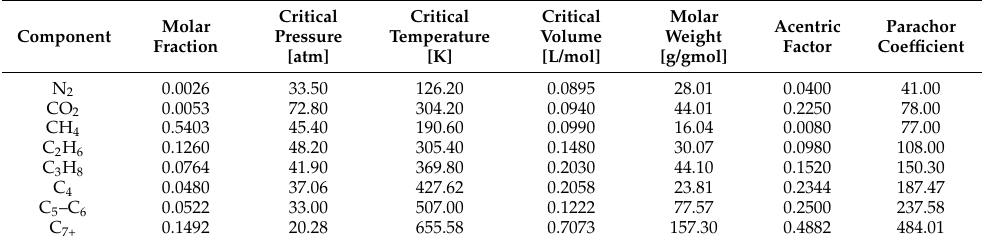
Figure 1. Gas-to-oil ratio (GOR) in the Duvernay shale and the location of the subject well (after Lyster et al. 2017) [23]. Table 1. Compositional data for the Duvernay volatile oil well.